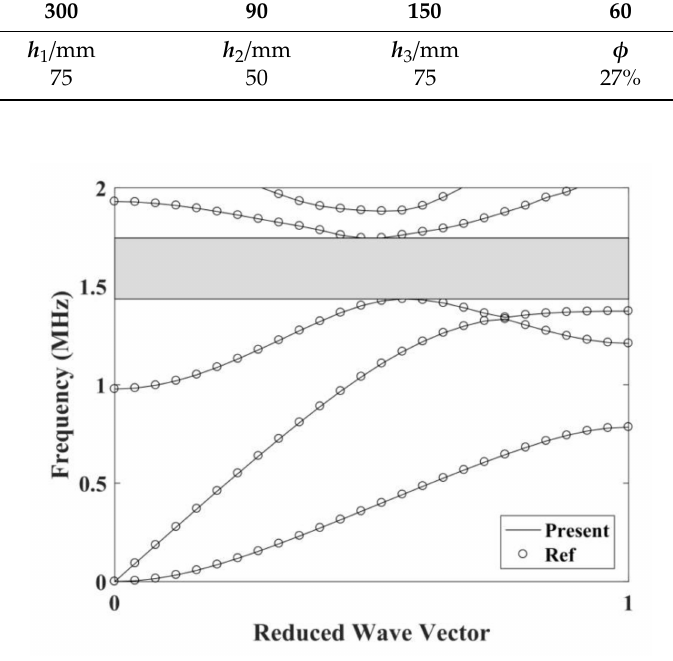
Figure 4. Dispersion